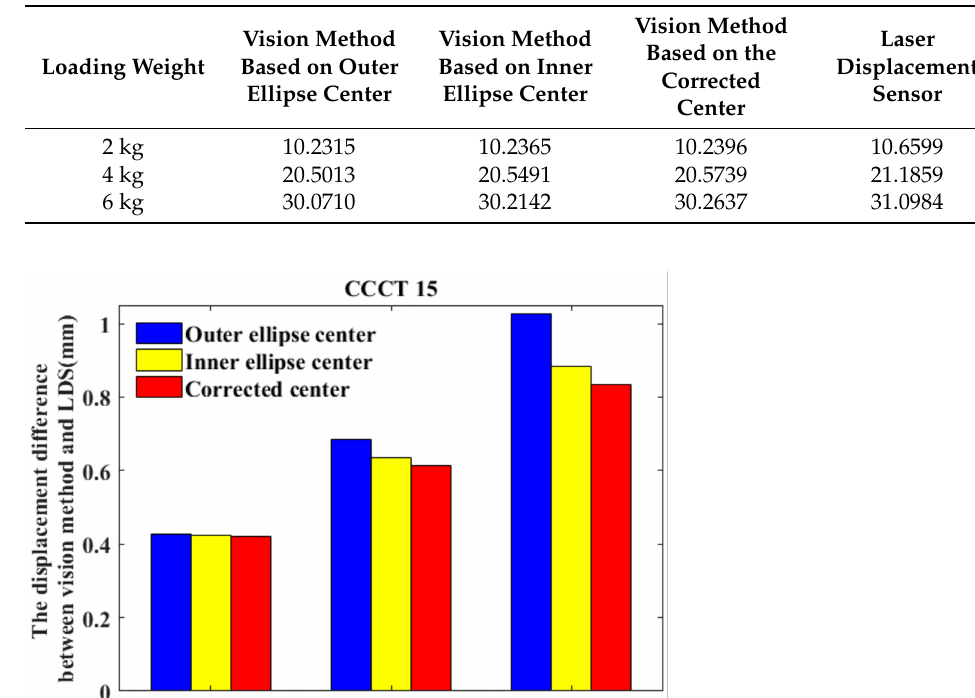
Table 2. The displacement of CCCT 15 on the wing.